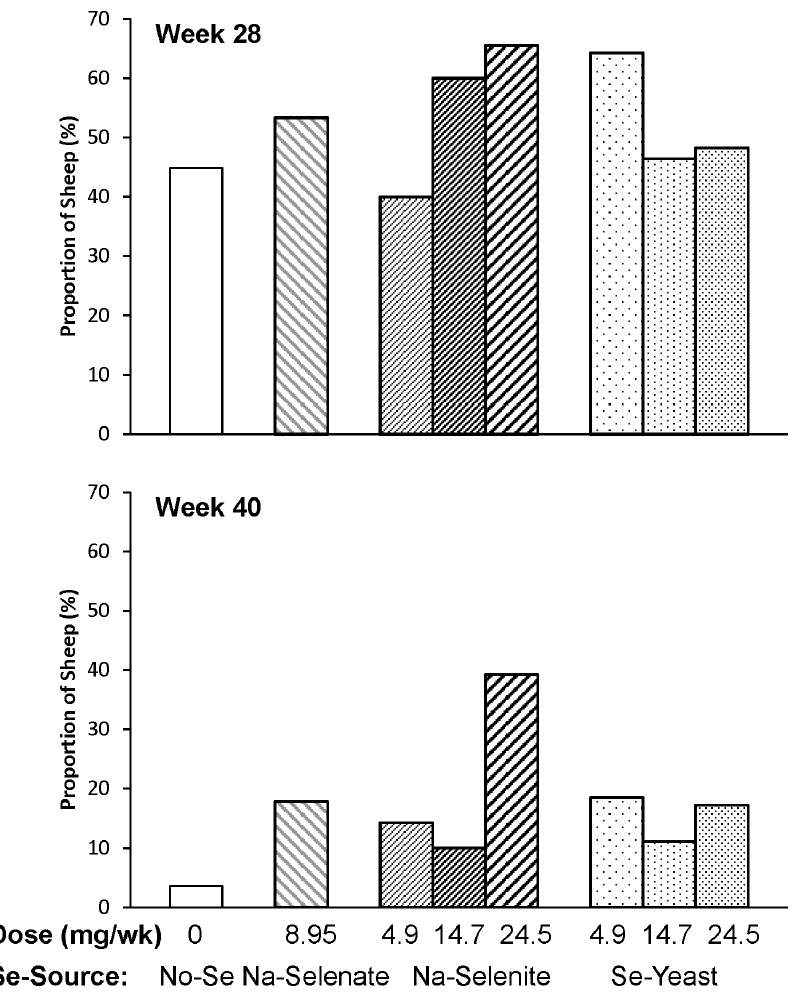
Figure 6. The effect of Se-source and dosage on sheep requiring oxytetracyline treatment. Foot rot severity was assessed after 0, 20, 28, 40, and 60 wk of Se supplementation in ewes receiving no Se treatment, Na-selenate at a dosage rate of 8.95 mg Se/wk per ewe, or Na-selenite and Se-Yeast at 4.9, 14.7, or 24.5 mg Se/wk per ewe for 62 wk. If a sheep had one foot with a score of 4, or one foot with a score of 3 and a second foot with a score of 2 or greater, or if all 4 feet had FR, then 20 mg/kg oxytetracycline was administered subcutaneously (Liquamycin LA-200; Pfizer Animal Health, Exton, PA) at the 28- and 40-wk foot trimming sessions. No significant differences in parental oxytetracycline treatment were observed for individual treatment groups at 28 wk; however; more ewes with supranutritional Na-selenite treatment were treated with oxytetracyline than ewes receiving the lowest Na-selenite dosage ( P =0.05). At 40 wk, more ewes receiving Na-selenite at the highest dosage had to be treated with oxytetracycline than ewes receiving no Se, Na-selenite at both lower dosages, or Se-yeast at 14.5 mg/wk (all P #